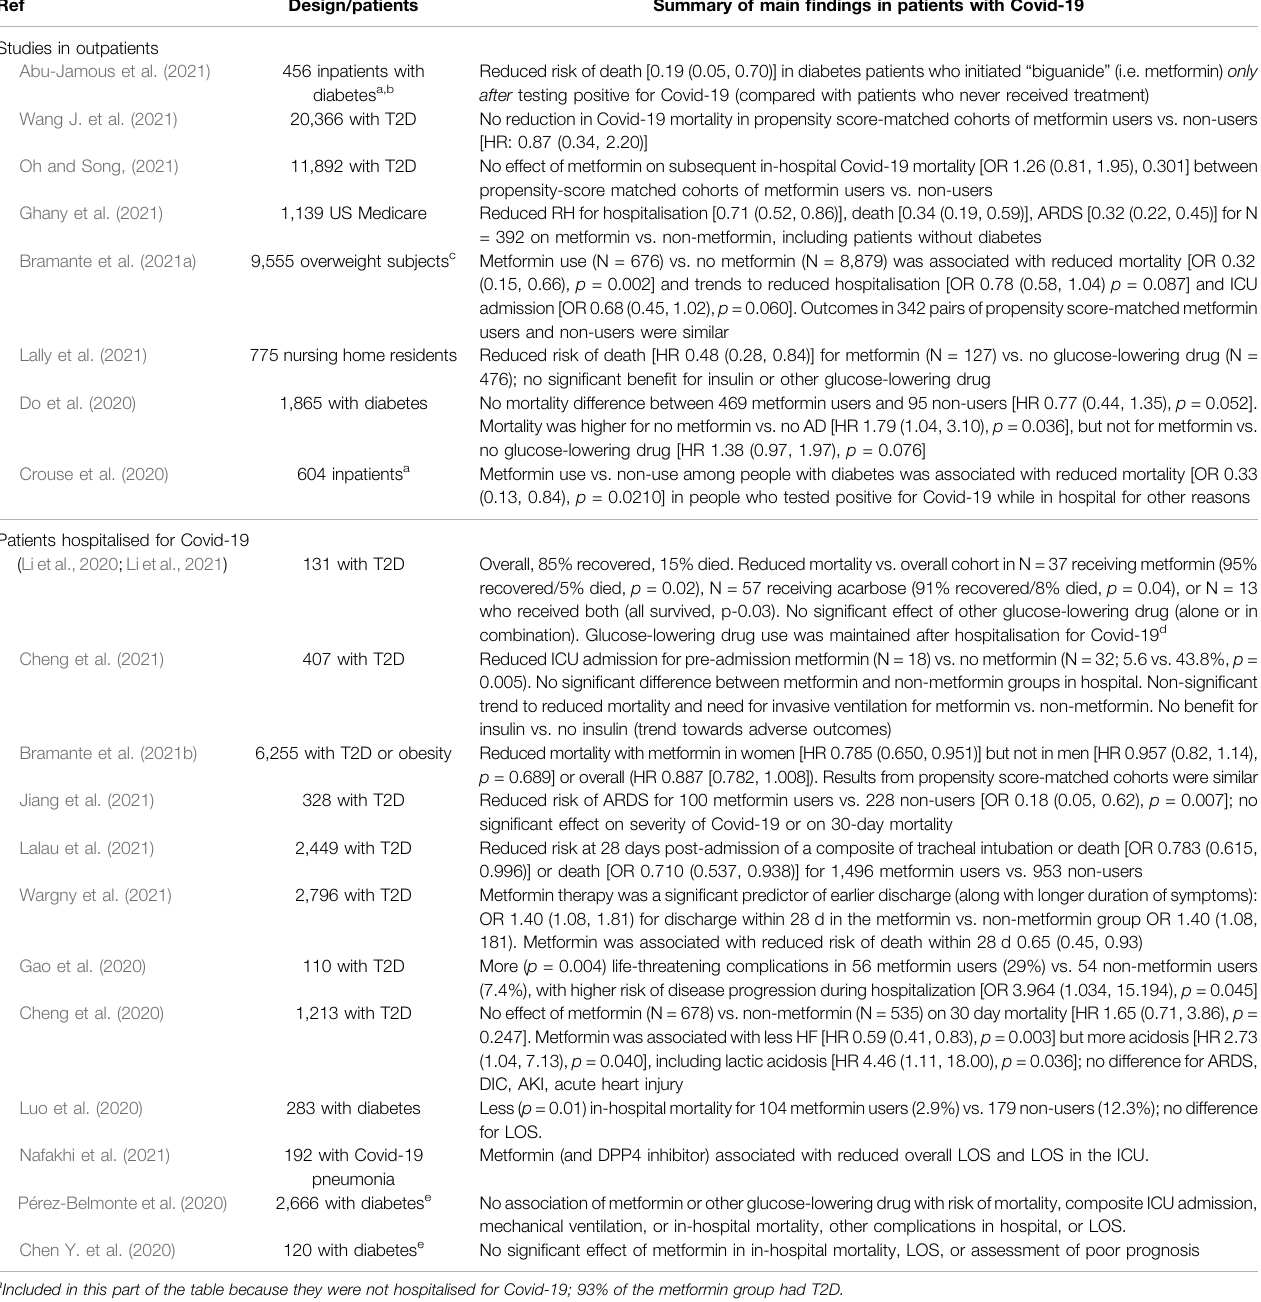
TABLE 1 | Overview of retrospective studies of the effect of metformin in people who became infected with SARS-Cov2 (Covid-19). Ref Design/patients Summary of main fi ndings in patients with